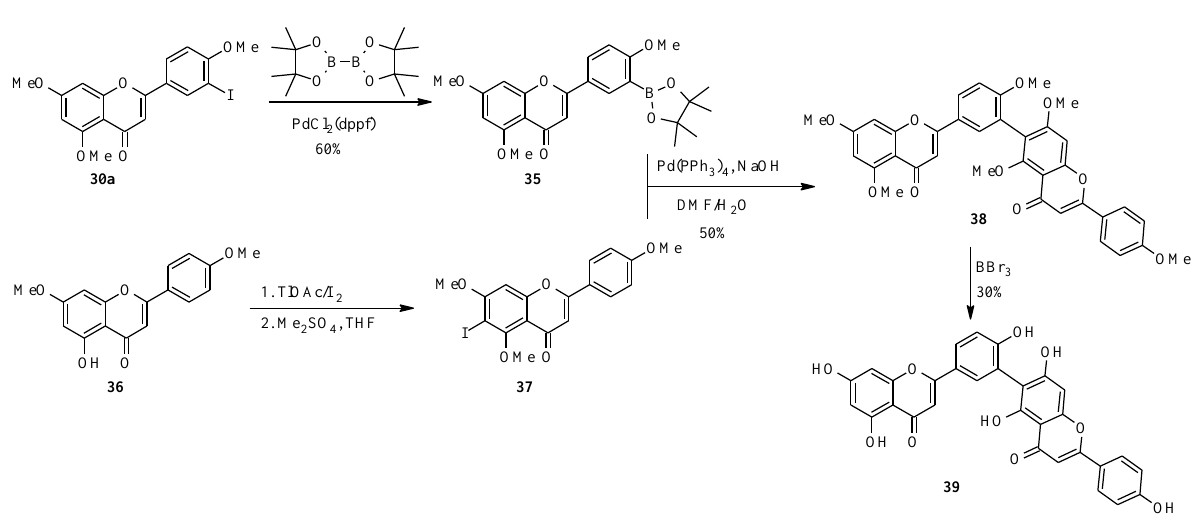
Scheme 10. Preparation of robustaflavone ( 39 )